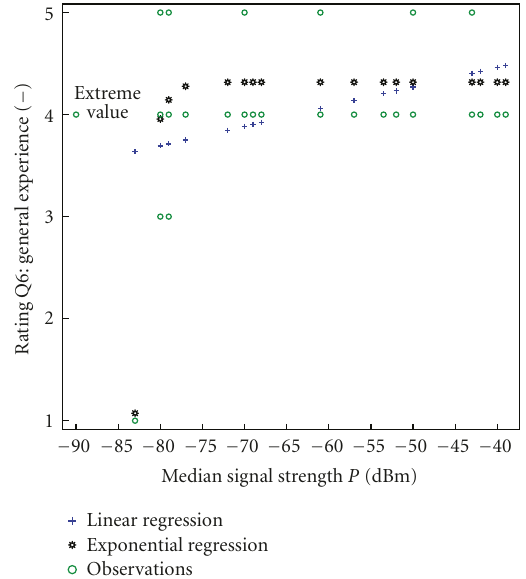
Figure 8: Rating of general experience (Q6) as a function of the monitored median signal strength and the regression